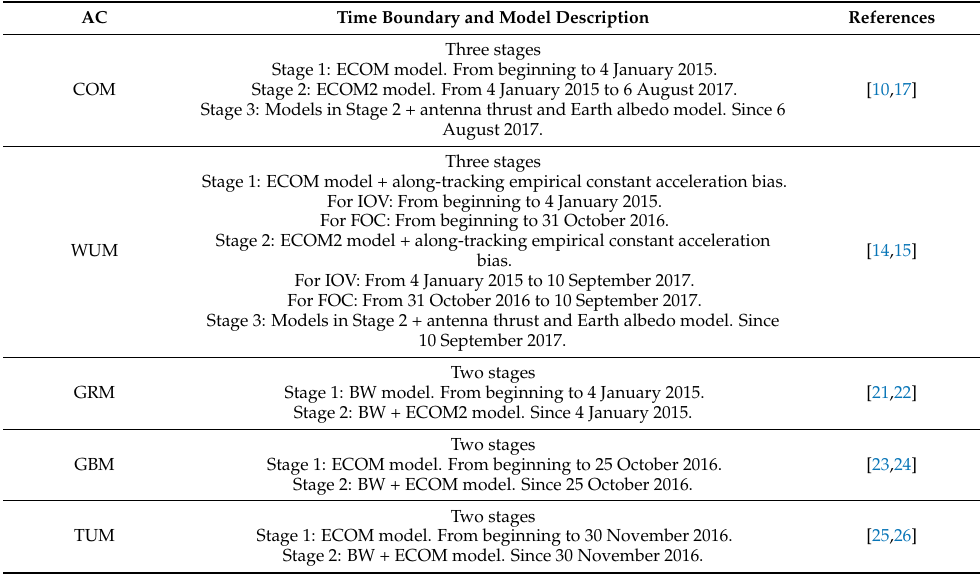
Stage 3: Models in Stage 2 + antenna thrust and Earth albedo model. Since 6